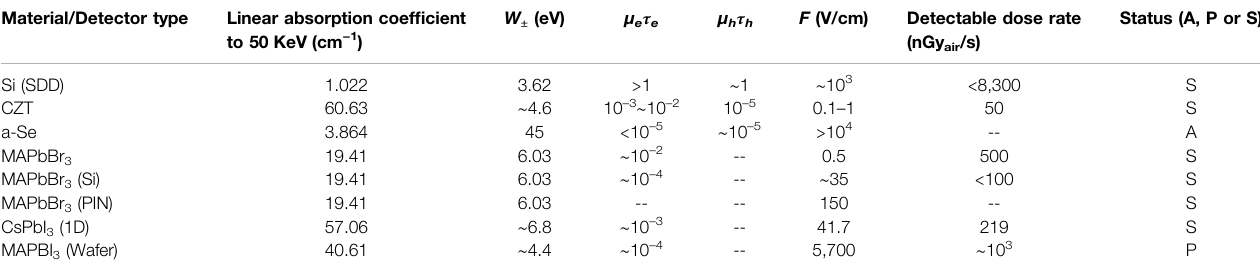
TABLE 1 | Performances and parameters of Si and a perovskite X-ray direct detector. W ± is the generation of carriers (EHP) creation energy. The central parameter is the productofcarriermobilityandmeancarrierlifetime( μ τ ),whichisnormallycalledtherangeofthecarrier.The F parameteristhelargestelectric fi eld.Inthe “ status ” column, A is amorphous, S is single-crystal, and P is polycrystalline. Material/Detector